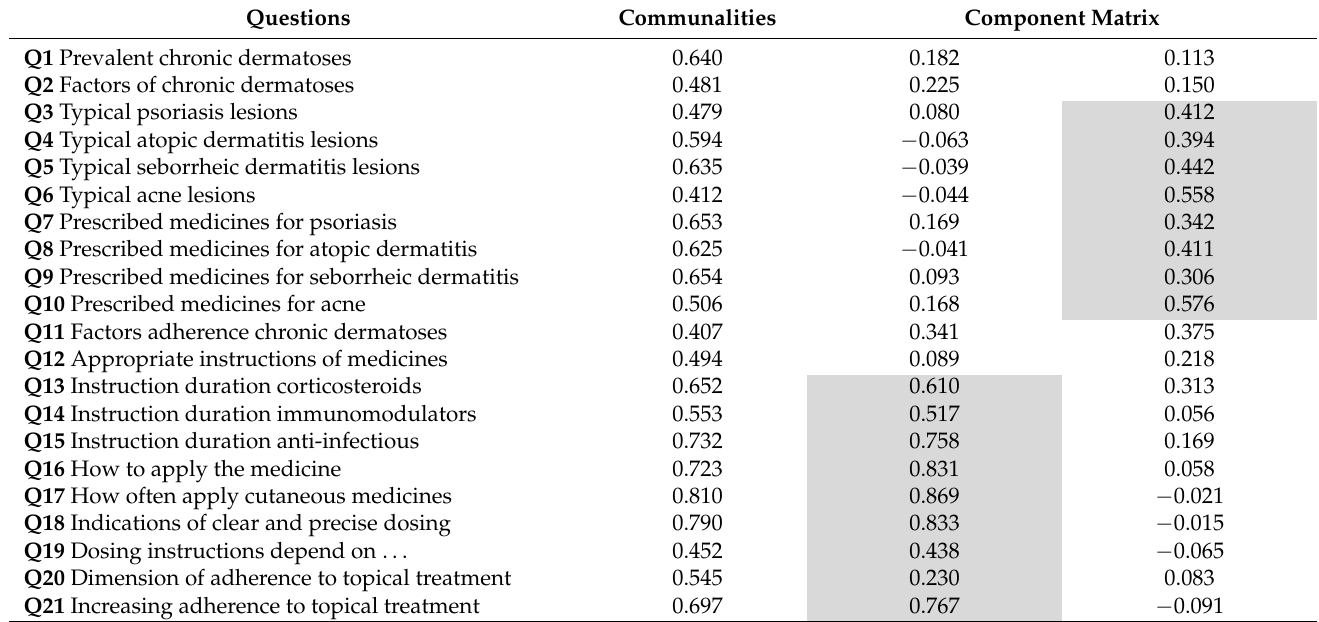
Table 3. Exploratory factorial analysis (EFA).